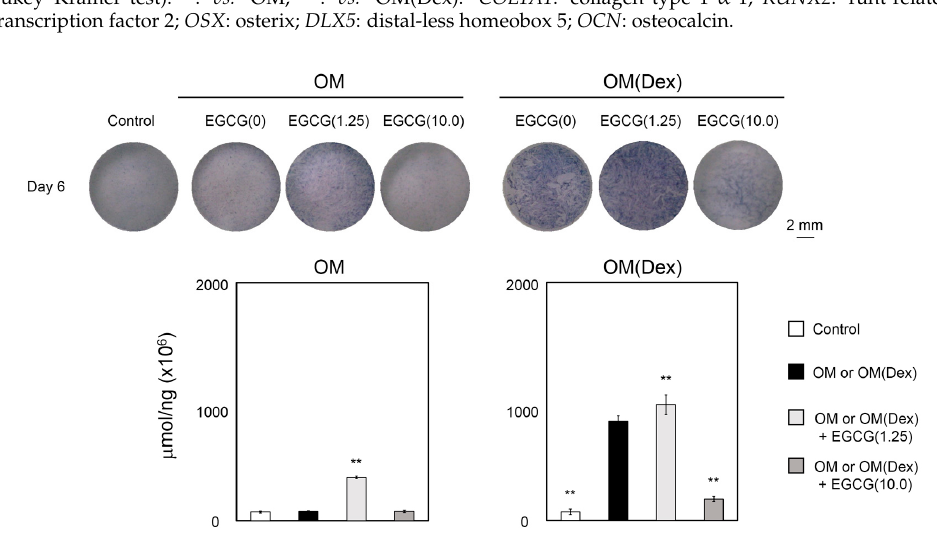
Figure 2. Alkaline Phosphatase (ALP) staining and the corresponding quantitative data for ALP expression of DFAT cells treated with or without EGCG in two different osteogenic media. OM: osteogenic medium without Dex; OM(Dex): OM with 100 nM Dex. Control: control medium. Cells were treated under condition 2. N in EGCG(N): concentration of EGCG ( µ M). ** p < 0.01 (ANOVA with a Tukey–Kramer test) indicates a statistically significant difference against OM or OM(Dex). The bar graph shows the mean with standard deviation ( n =